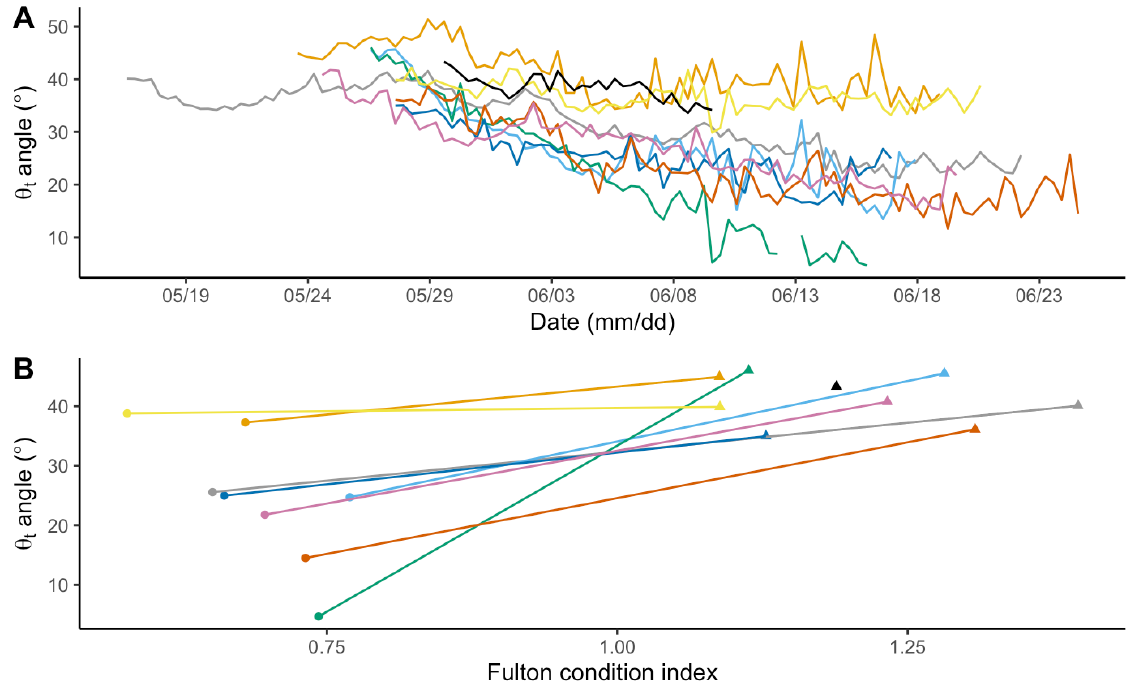
Figure 6 . The q t angle between the x-axis of the accelerometer and the vertical plane as an indicator of fish body roundness A. Temporal evolution of q computed each day along the spawning season for nine Allis shad. B. Relationship between Fulton coefficient of condition and q t angle at initial release (triangles) and at recapture after death (points). Each individual is represented with the same colour as in Fig. 3, and black is for the individual whose tag stopped recording before the end of the